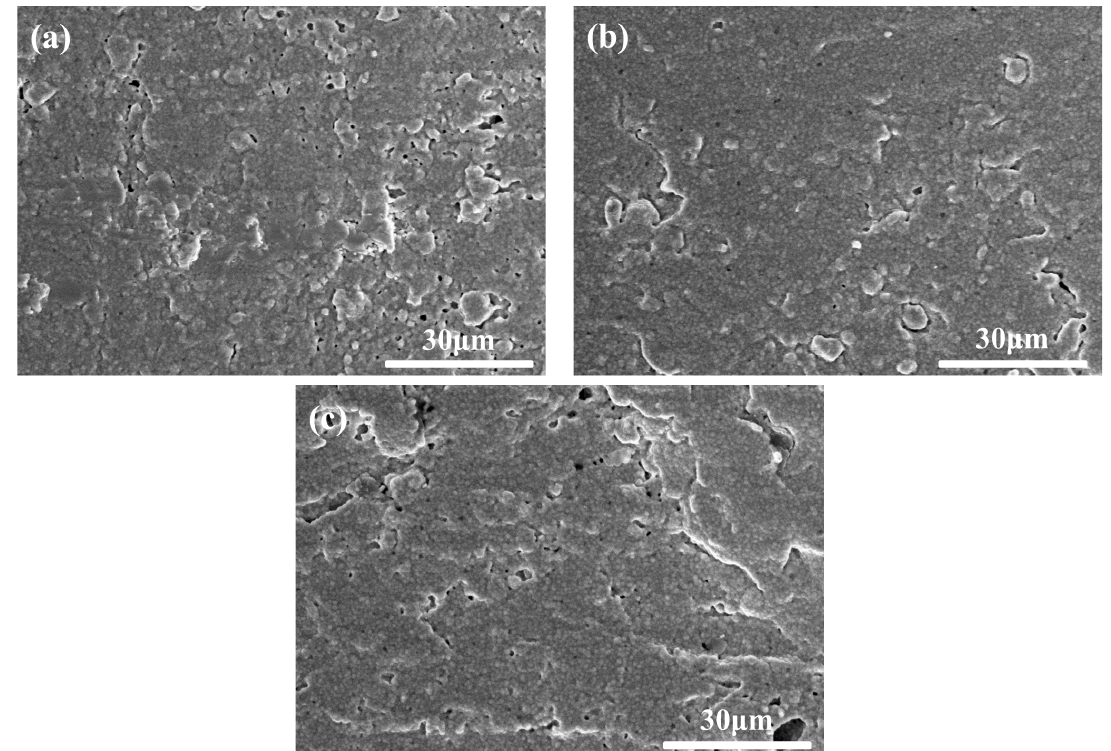
Figure 15. Surface morphologies of the sintered parts with different sintering temperatures for 2 h. ( a ) 1500 ◦ C, ( b ) 1525 ◦ C, and ( c ) 1550 ◦